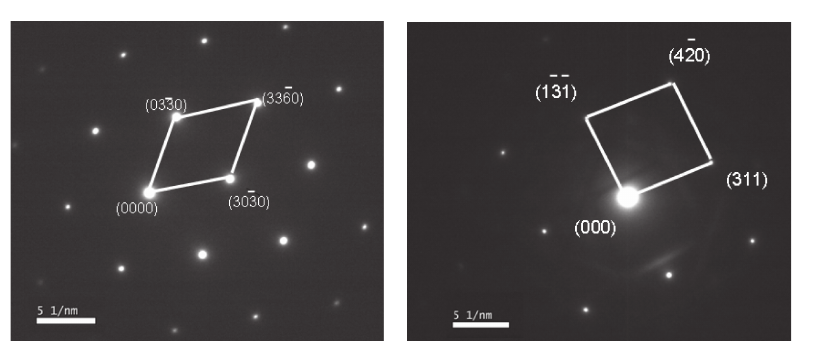
Figure 8: Electron diffraction patterns and indexing results of composite core-containing